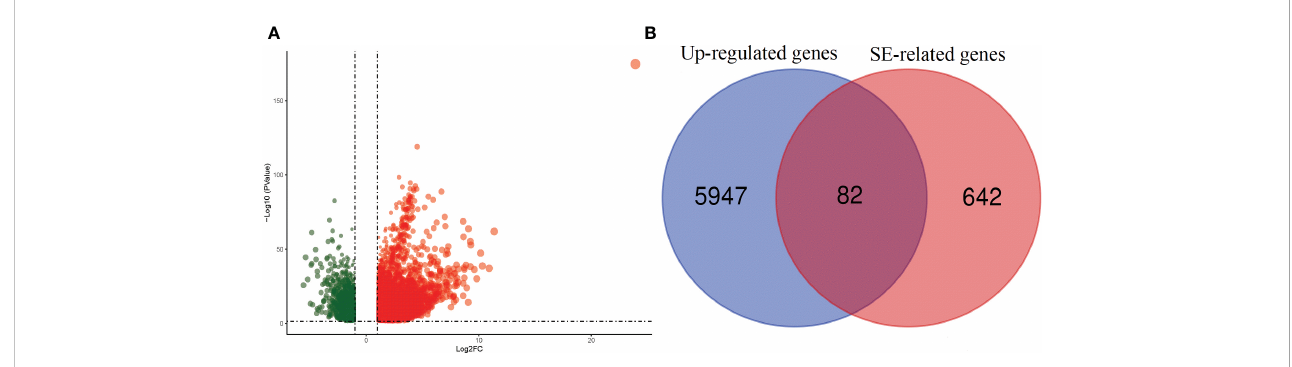
FIGURE 1 Volcano plot and Venn Diagram. (A) Volcanic Map of differentially expressed genes in TCGA of HCC Transcriptome data. (B) Wayne diagram shows the super enhancer related target genes in different